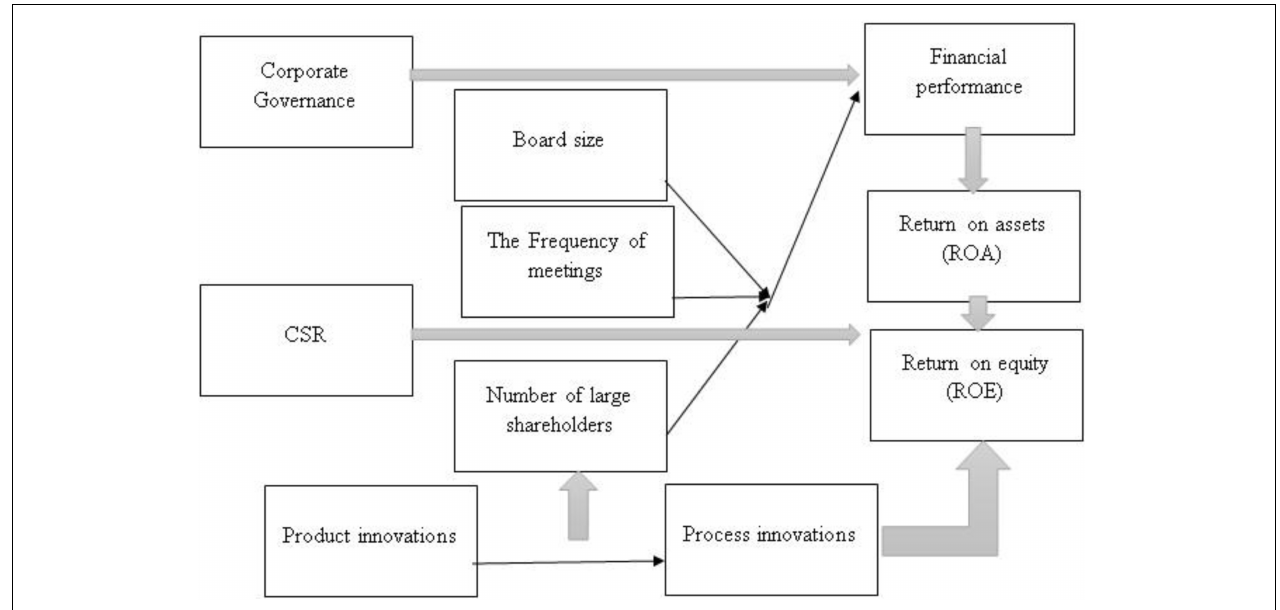
FIGURE 1 | Theoretical